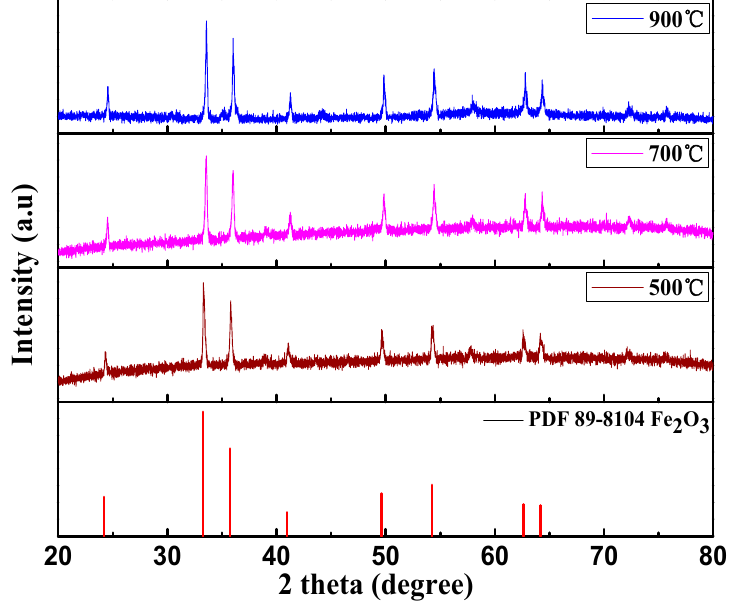
Figure 4. XRD patterns of Fe 2 O 3 at different temperatures.